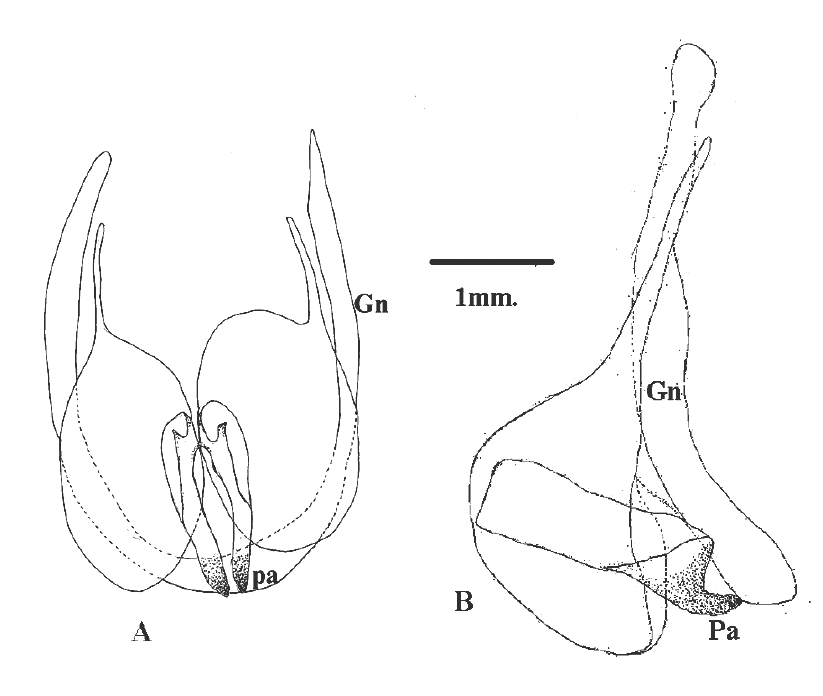
FIG . 8.- Male genitalia of Myrmeleon (M)hyalinus .A; ventral view ,B-lateral